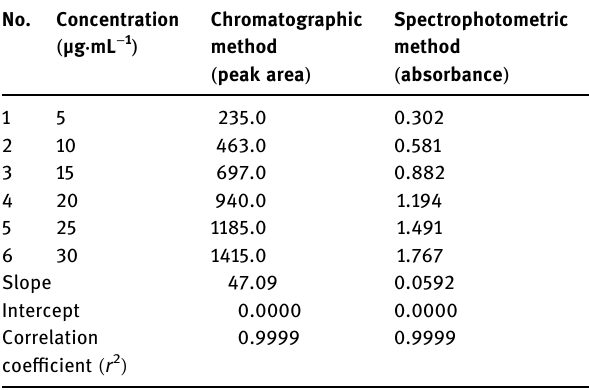
Table 2: The results of regression analysis No. Concentration ( μ g · mL − 1 )